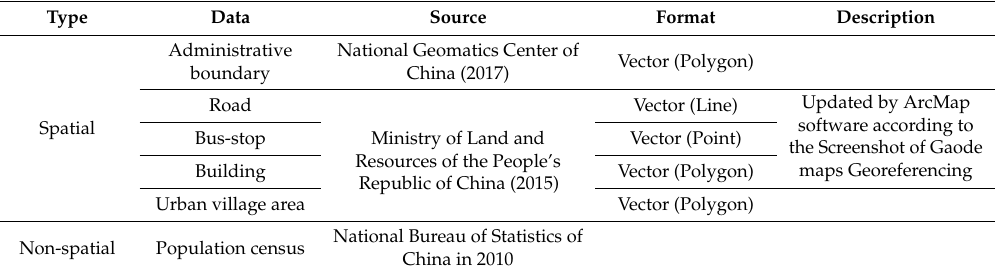
Table 1. List of data used.